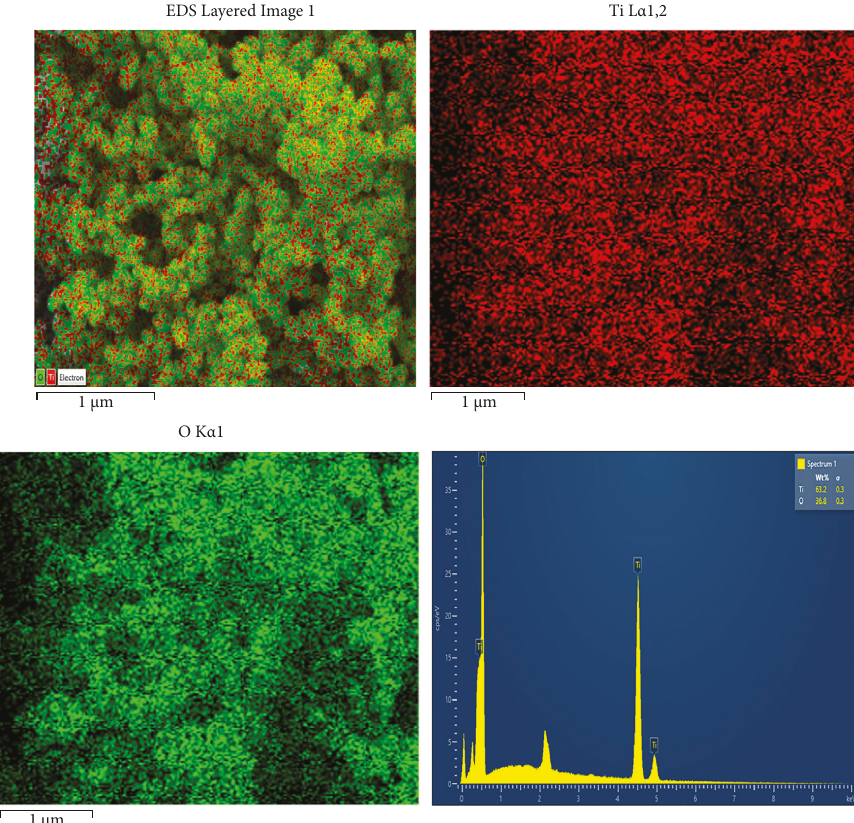
Figure 3: EDX analysis and elemental mapping of TiO